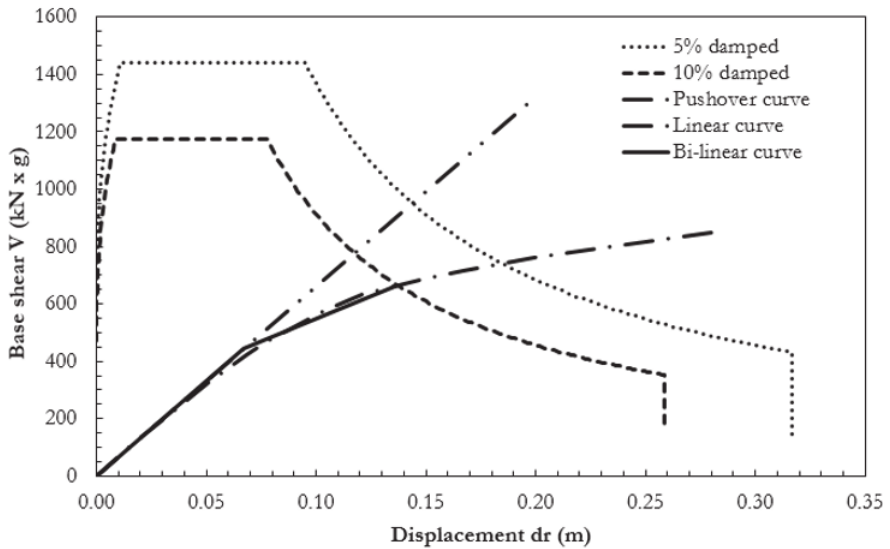
Response spectra, linear curve, bi-linear curve and pushover curve. The pushover analysis refers to the second mode on the x direction for K’ = 0.5 K. The maximum allowed displacement is 13.74 cm (intersection between pushover curve and response spectrum for 10% damped)